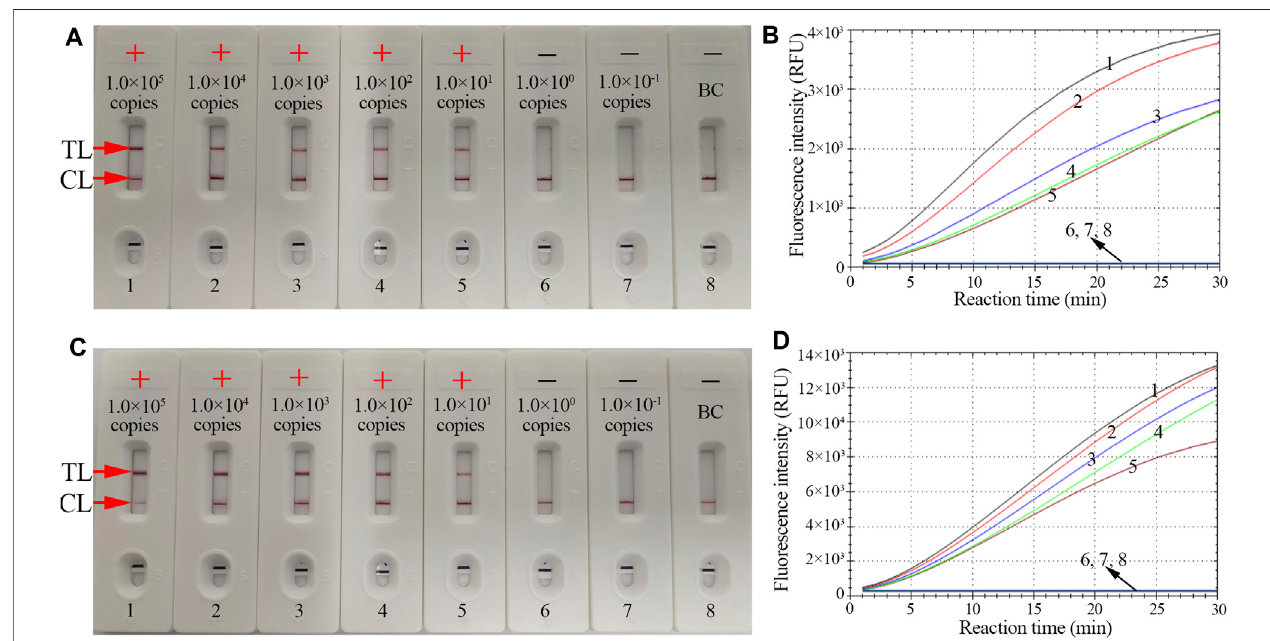
FIGURE4 | The sensitivity oftheCRISPR-HBV assay. LFBand RTF techniques were simultaneously applied for reportingthe CRISPR-HBV assay results. LFB (A) andRTF (B) 1 – 8representtheHBVgenotypeB- S plasmidconcentrationsof1 × 10 5 ,1 × 10 4 ,1 × 10 3 ,1 × 10 2 ,1 × 10 1 ,1 × 10 0 ,and1 × 10 -1 copiesperreactionandthe blankcontrol(DW),respectively.LFB (B) andRTF (D) 1 – 8representtheHBVgenotypeC- S plasmidconcentrationsof1 × 10 5 ,1 × 10 4 ,1 × 10 3 ,1 × 10 2 ,1 × 10 1 ,1 × 10 0 , and 1 × 10 -1 copiesper reaction and theblank control (DW), respectively.The LoD ofthe CRISPR-HBV assay was10 copies per reaction. CL: control line; TL: test line; “ + ” : positive; “ − ” : negative.